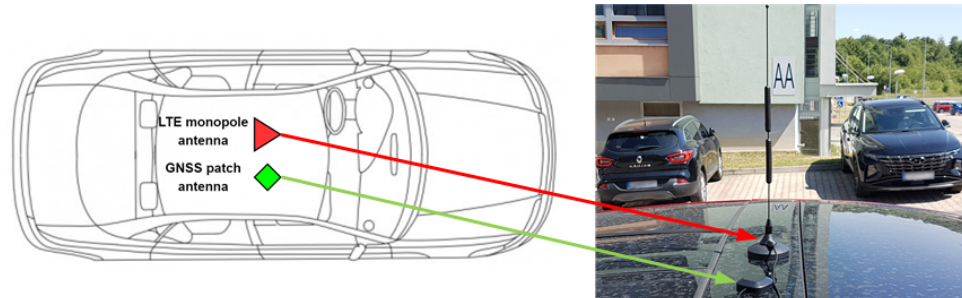
Figure 2. Antenna placement